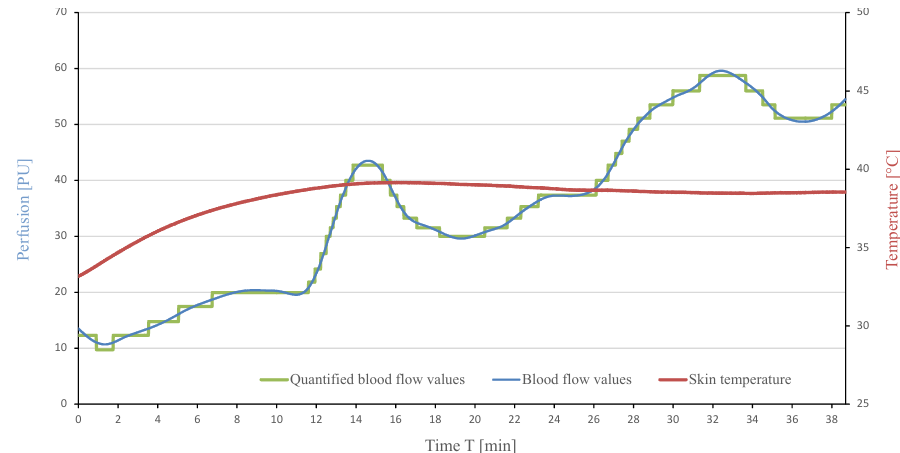
Figure 14. Blood flow values and its corresponding quantified